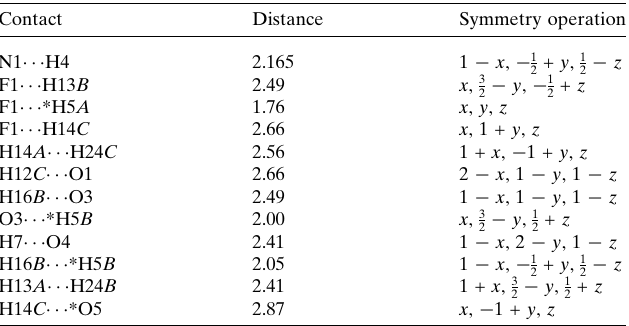
Fig. 6 c ) and C (cid:2) (cid:2) (cid:2) H/H (cid:2) (cid:2) (cid:2) C (15.5%; Fig. 6 d ) interactions. Other interactions contributing less to the crystal packing are from F (cid:2) (cid:2) (cid:2) H/H (cid:2) (cid:2) (cid:2) F (6.7%), N (cid:2) (cid:2) (cid:2) H/H (cid:2) (cid:2) (cid:2) N (4.5%), S (cid:2) (cid:2) (cid:2) H/H (cid:2) (cid:2) (cid:2) S